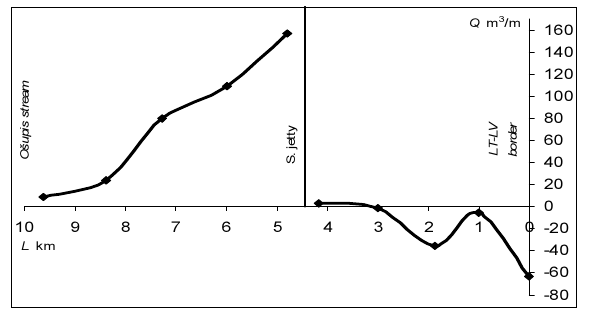
3 Fig. 5. Sediment changes (m /year) in the coastline section from the Ošupis stream to the Latvian border from 1993 to 2010